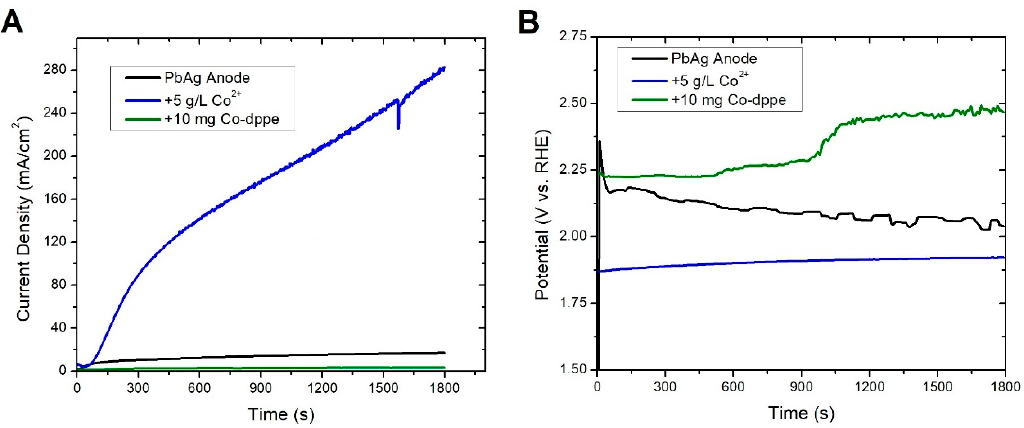
Figure 5. ( A ) Chronoamperograms at constant potential (2.06 V vs. RHE) and ( B ) chronopotentiograms comparing the Co 2+ -containing electrolyte (in blue), PbAg anode without any water oxidation catalytic metal additives (black), and Co-dppe coated PbAg anode (green).